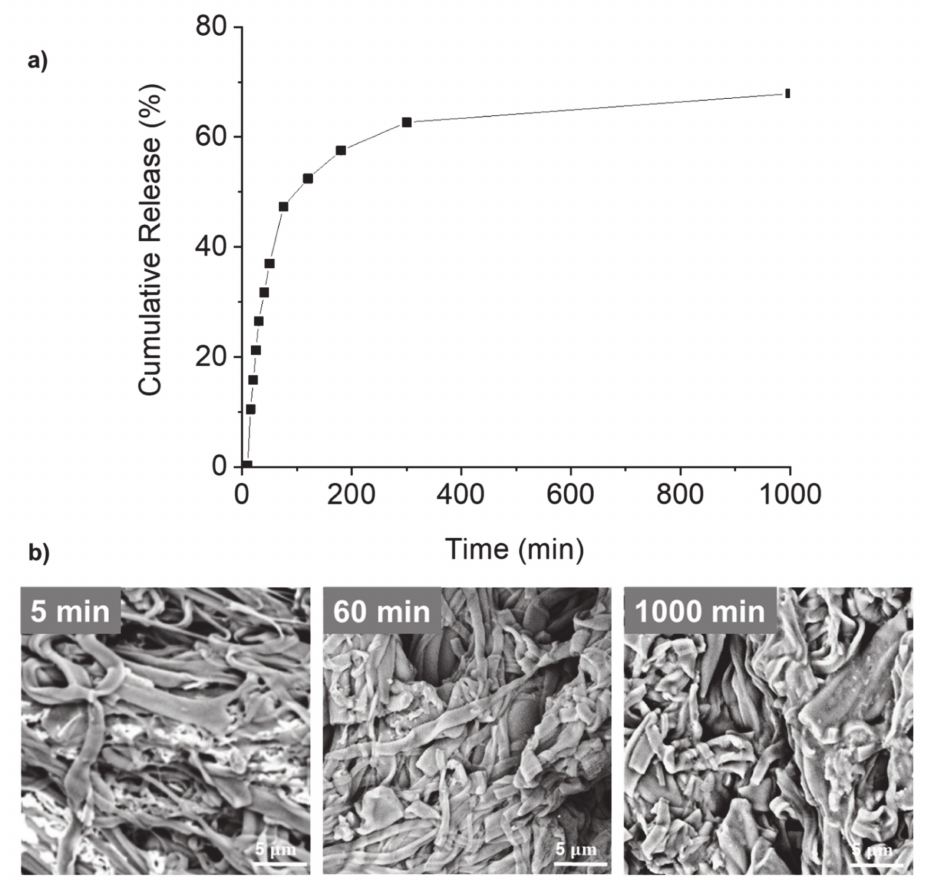
Figure 7. ( a ) Cumulative release of vitamin B12 from electrospun potato protein fibers immersed in phosphate-bu ff ered saline (PBS) solution (pH = 7.4, 37 ◦ C). ( b ) SEM images of the electrospun potato protein fibers after their immersion in PBS (37 ◦ C) for 5 min, 60 min and 1000 min ( n =